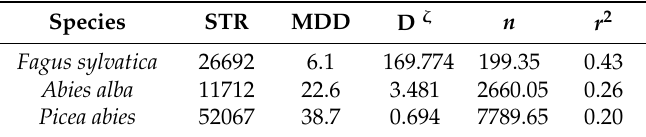
Table 2. Model parameters and results of the models of seed dispersal for Picea abies, Abies alba and Fagus sylvatica using the “recruits-model” [45]. Species STR MDD D ζ